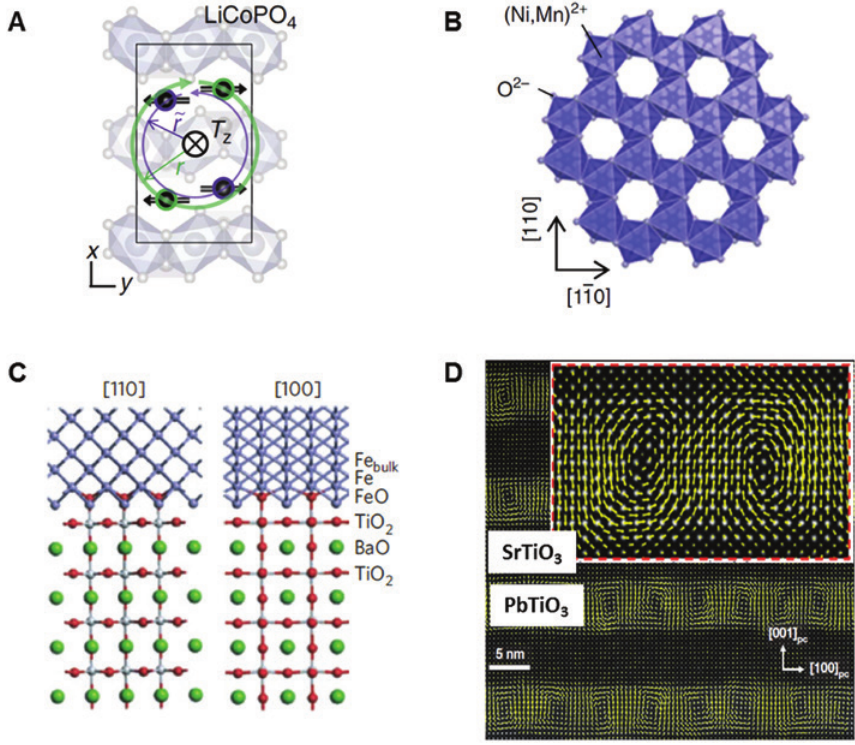
Figure 2: Examples of toroidal moment in materials. (A) Z-component of the toroidal moment in LiCoPO originated from two spin pairs in Co 2 + shown for its magnetic unit cell (rectangle) [53]. 4 Because of the different radii < (cid:31) , r r the clockwise and counterclockwise contributions from these two pairs do not cancel. (B) Crystal struc- ture of Ni Mn TiO projected along the hexagonal c axis [001] [81]. (C) Structural model of the interface type (-Fe-FeO-TiO x 1−x 3 Fe and BaTiO [92]. (D) An array of vortex-antivortex pairs present in each PbTiO layer indicated by polar displacement vectors (yellow 3 3 arrows) [93]. Figures reproduced with permission from (A) Ref. [53], NPG; (B) Ref. [81], NPG; (C) Ref. [92], NPG; (D) Ref. [93],